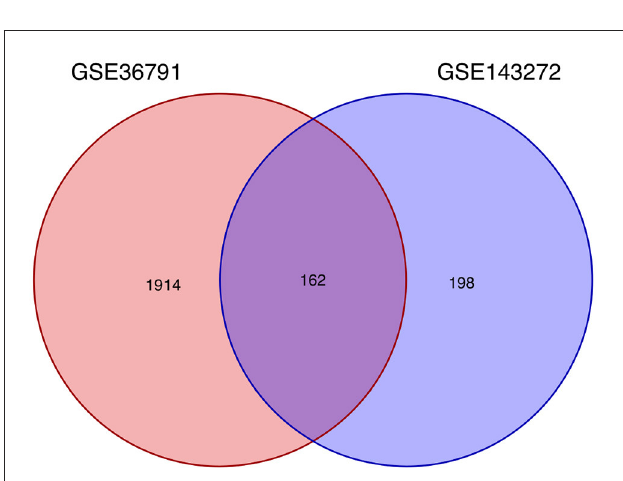
FIGURE3 Intersecting genes of GSE36791 and GSE143272. Red and purple represent GSE36791 and GSE143272,